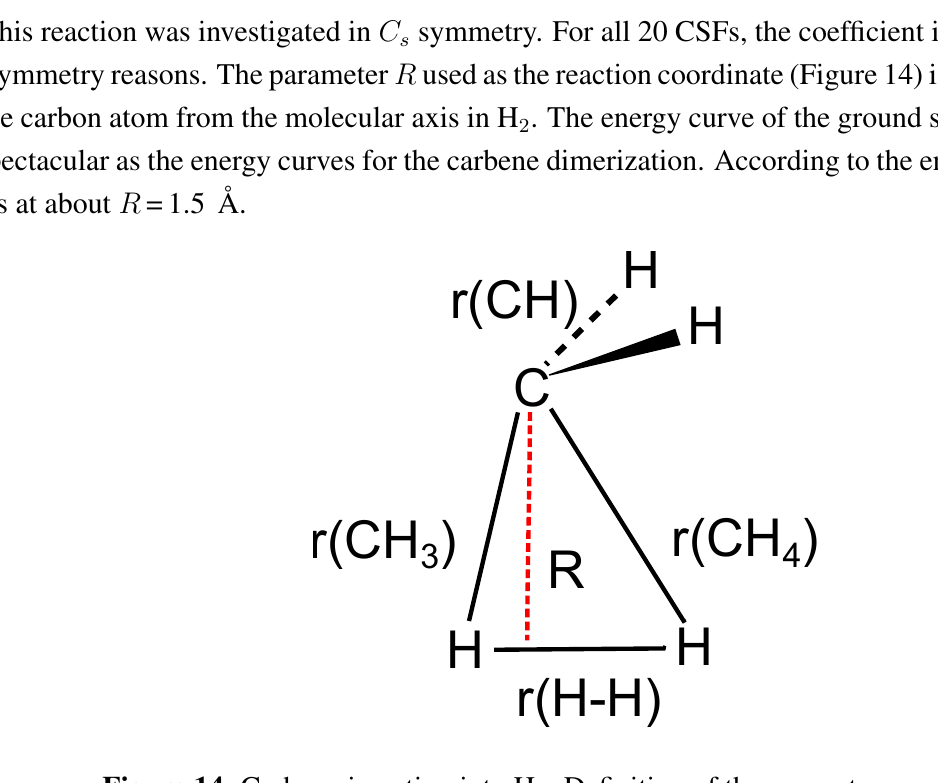
Figure 14. Carbene insertion into H 2 . Definition of the geometry